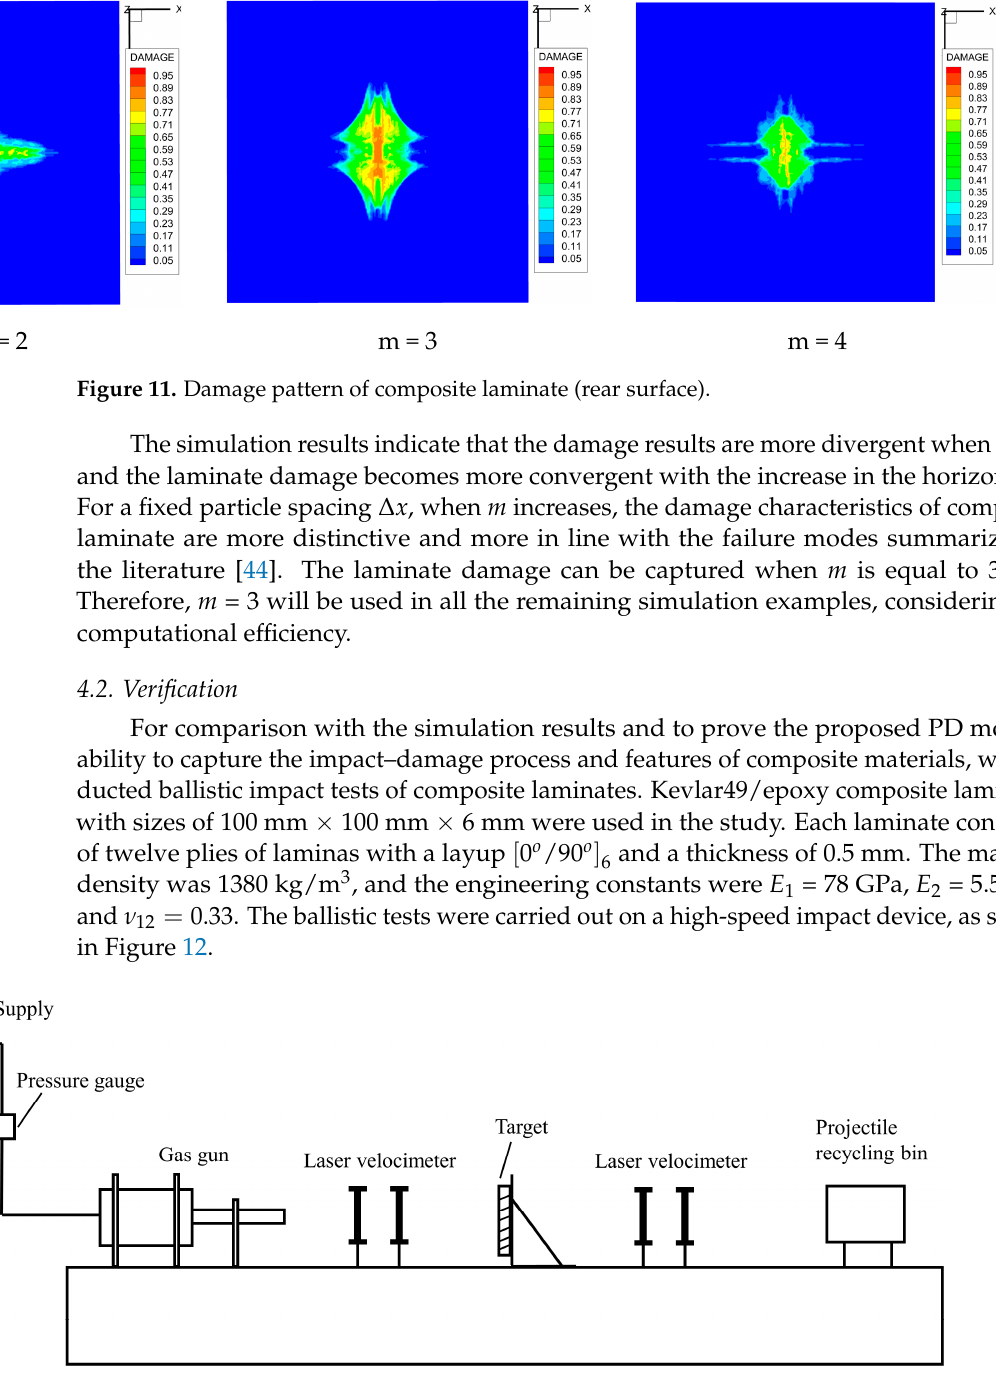
Figure 10. Damage pattern of composite laminate (front surface).